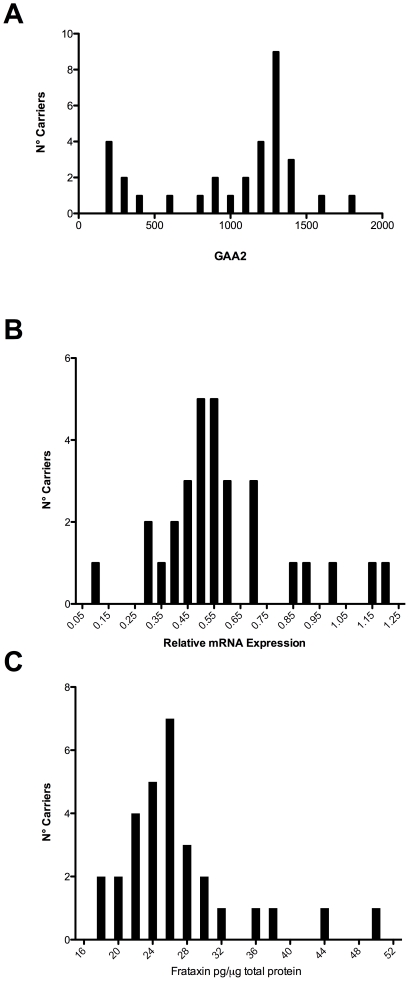
Non normal distribution of GAA2, FXN mRNA and frataxin protein in carriers.A) Bimodal distribution of GAA2 repeats in carriers; B) skewed distribution of FXN mRNA levels in carriers; C) skewed distribution of frataxin protein levels in carriers.